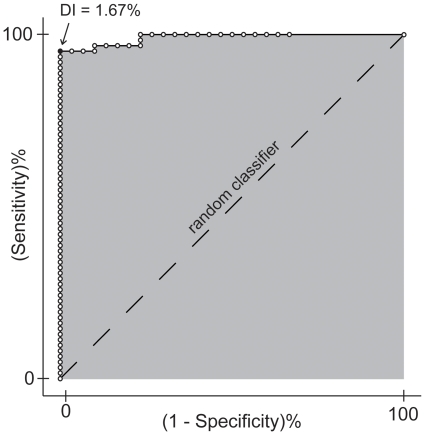
ROC analysis applied to the DI. ROC curve is depicted as a solid black line, interspersed by blank dots representing the values of sensitivity and specificity (repeatability) associated to single DI values.The optimal DI value of 1.67% computed according to the Younden index [34] is shown as a black dot. Dashed line represents the ROC curve of a random classifier. Gray-shaded region indicates the area under the curve.